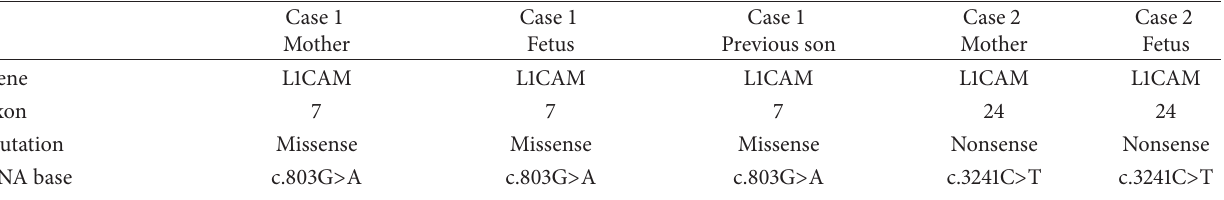
Table 1: Genetic information of the mutation detected in our cases.